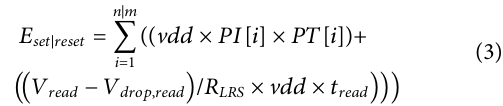
Frontiers in Nanotechnology |